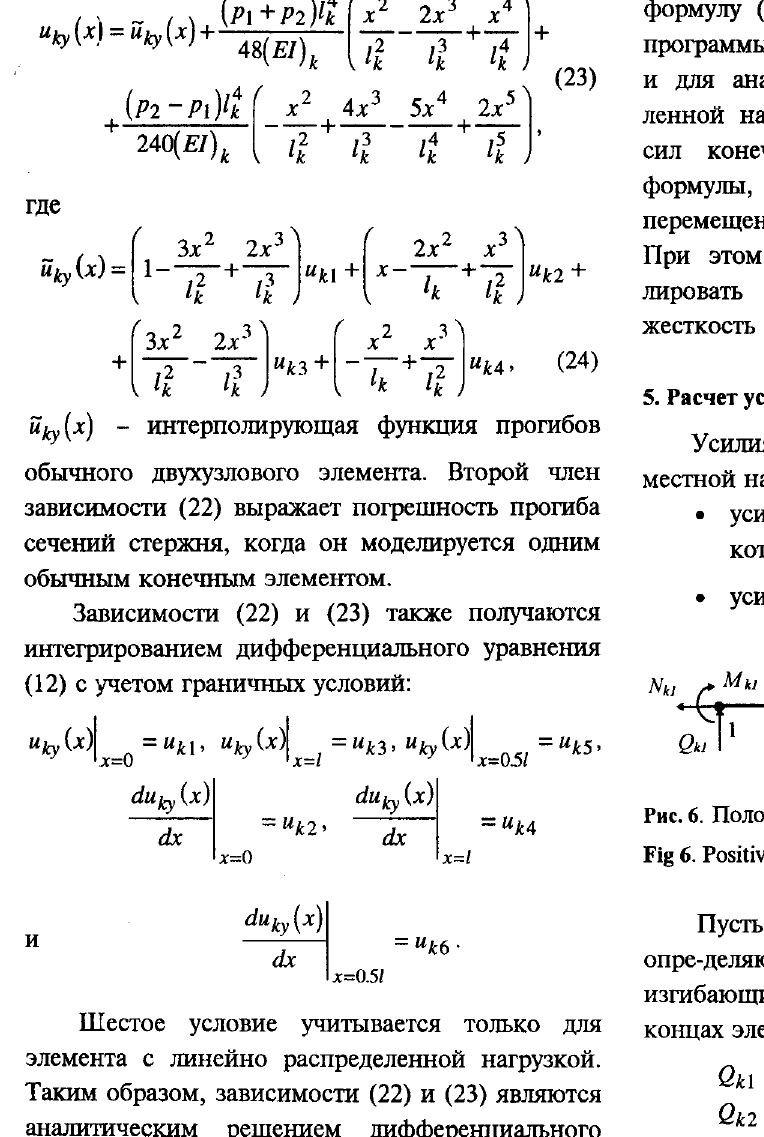
Fig 6. Positive directions of stresses IlyCTh rroJIOXHTeJibHhle HarrpaBJieHM.SI ycHJ!Mit